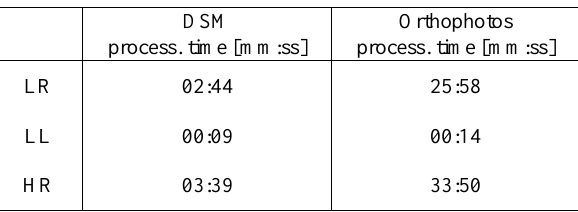
Table 8. DSMs and orthophotos statistics in UAV photogrammetric process.